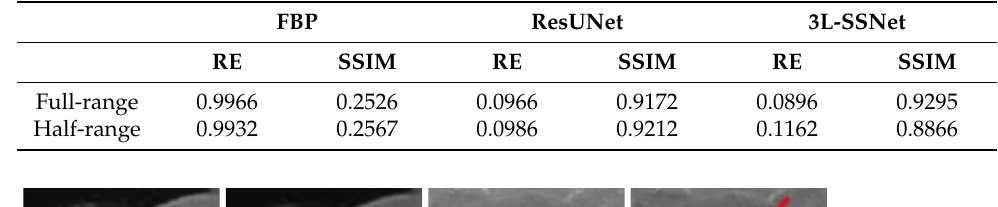
Figure 7. Half-range geometry reconstructions. The results obtained with FPB ( left column ), ResUNet ( central column ) and 3L-SSNet ( right column ). Below each image, the values of its RE and SSIM metrics. Table 4. Full-reference metrics on the test image with unseen noise in full-range and half-range cases.